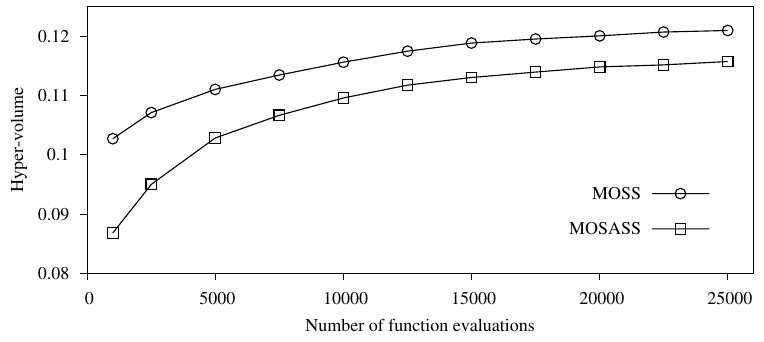
Figure 6. Values of hyper-volume, obtained using different algorithms and different numbers of function evaluations